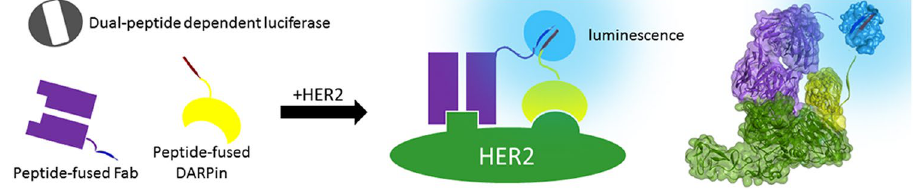
Figure 1. Scheme of Target Engaged Complementation (TEC), utilizing a reporter split into inactive components. Two fragments of the split reporter are each fused to an individual binding proteins such as an antigen binding fragment (Fab) or Designed Ankrin Repeat Protein (DAPRin) that bind specifically to a non- overlapping domain of a target protein. As the two target proteins interact, the antibody-fusions are forced into proximity, inducing enzyme-complementation and luminescent